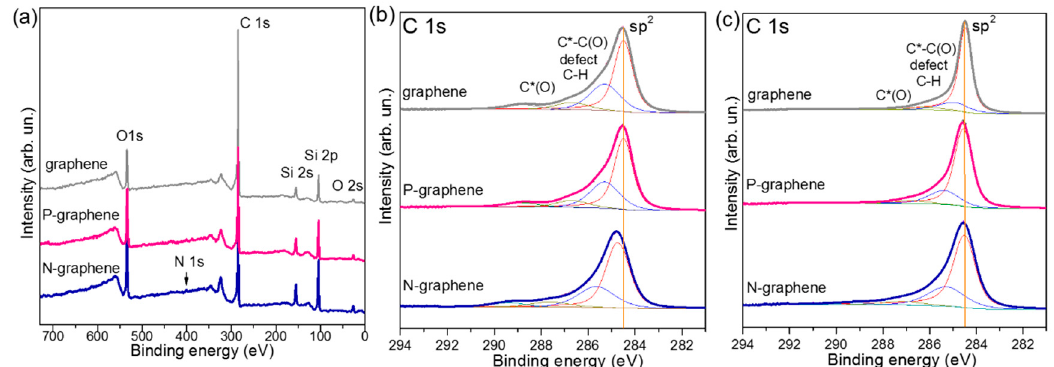
Figure 2. ( a ) Overall X-ray photoelectron spectroscopy (XPS) spectra of pure graphene, P-graphene, and N-graphene films annealed in spectrometer chamber at 773 K; Comparison of C 1s XPS spectra of pure graphene, P-graphene, and N-graphene films measured before ( b ) and after ( c ) annealing.